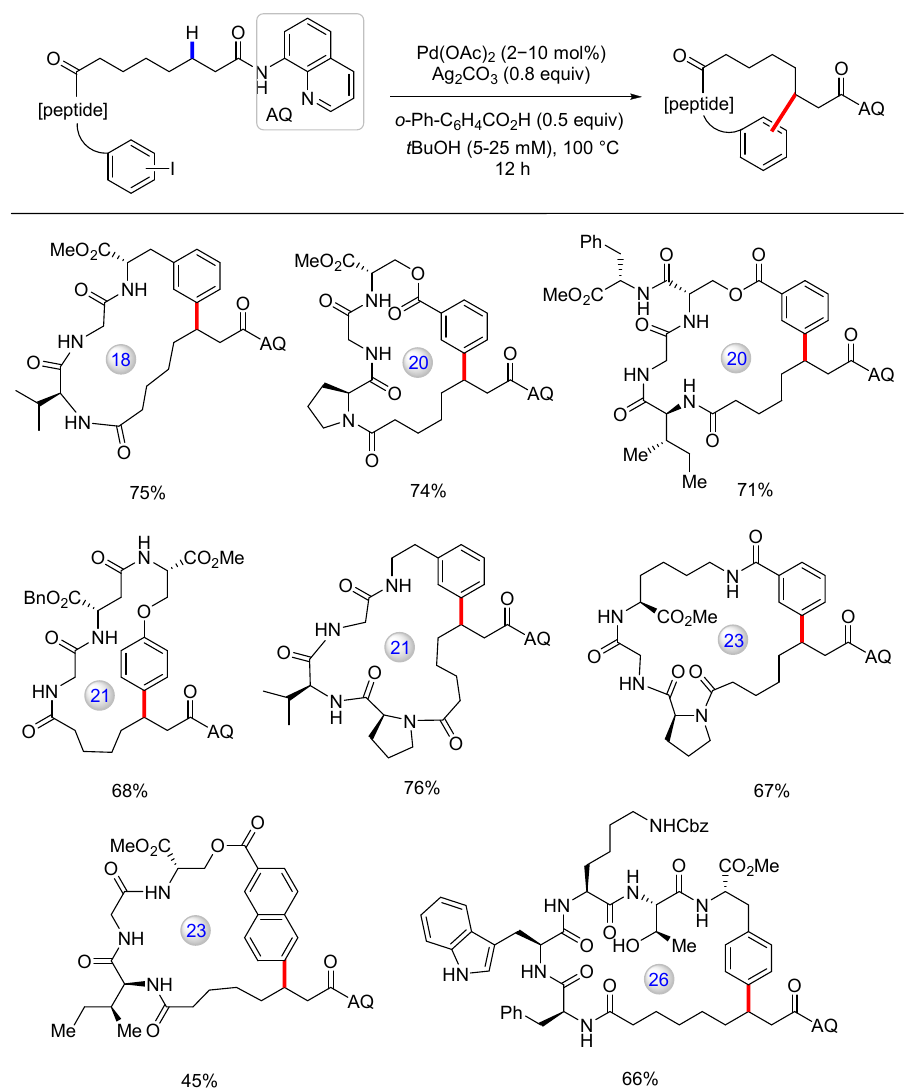
Figure 20. Synthesis of cyclophane-braced peptide macrocycles via palladium-catalyzed intramolecular C(sp 3 ) − H arylation [86].